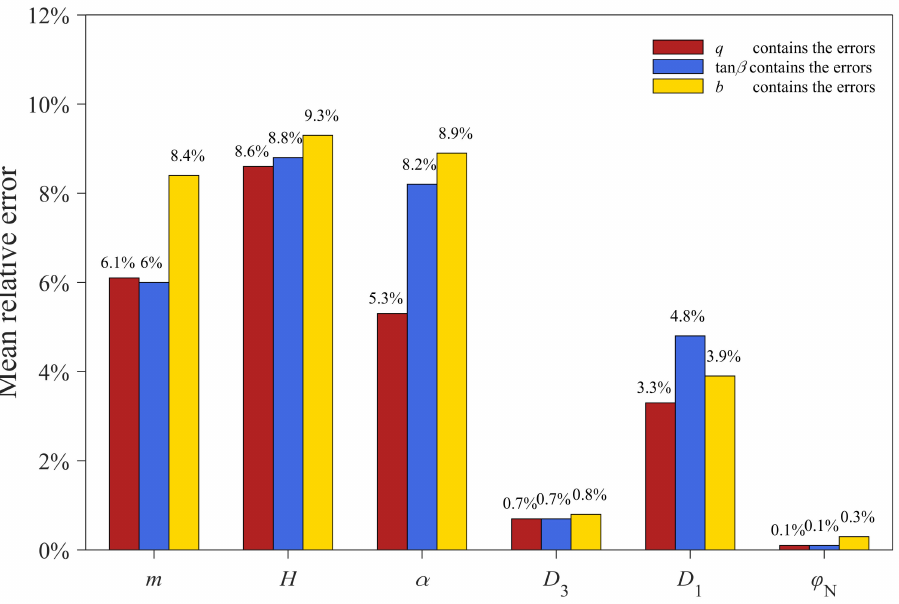
Figure 12. Calculated average relative error of the goaf parameters except origin coordinates of the local plane coordi- nate